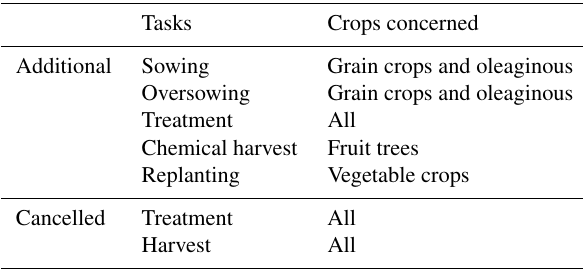
Table 5. List of additional or cancelled tasks taken into account in